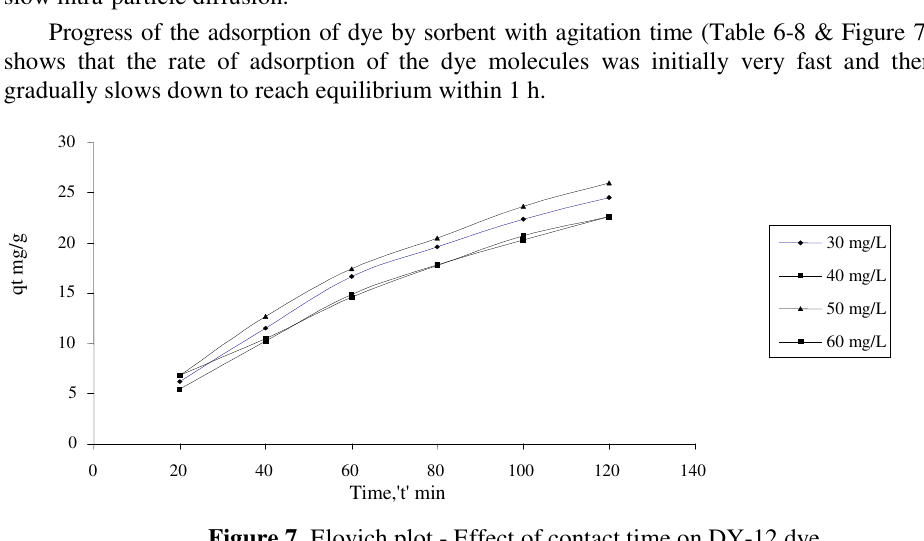
Figure 7. Elovich plot - Effect of contact time on DY-12